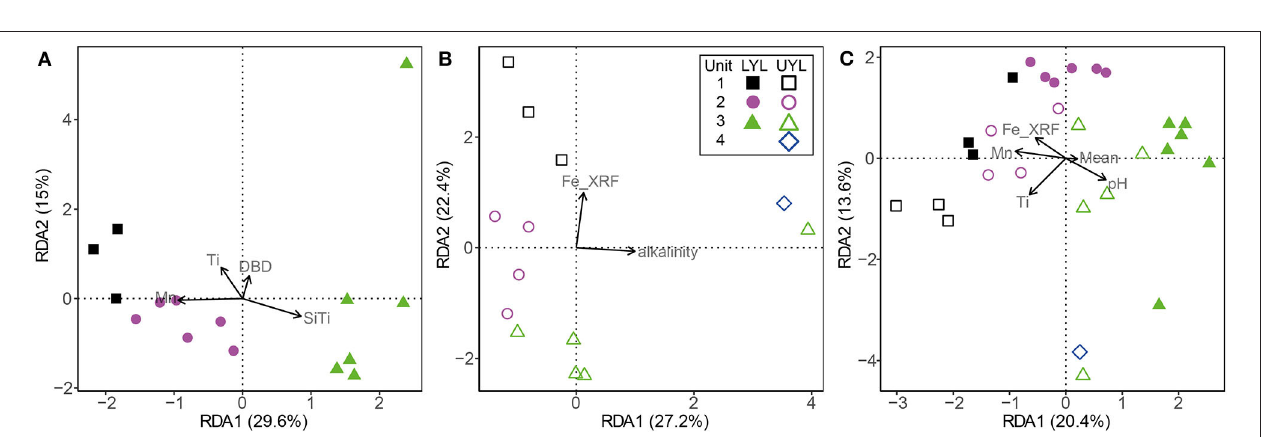
FIGURE 6 | Ordination plot for first and second axes of variance from RDA of the microbial community composition in LYL on class level. (A) LYL (filled shapes), (B) UYL (hollow shapes), and (C) YL. Constraints were selected to constitute a minimum adequate model best explaining the variance in the microbial community structure data. Unit 1: black squares; unit 2: purple circles; unit 3: green triangles; unit 4: blue diamonds. Axis labels denote percentage of total variance explained by the respective principal components (PCs).